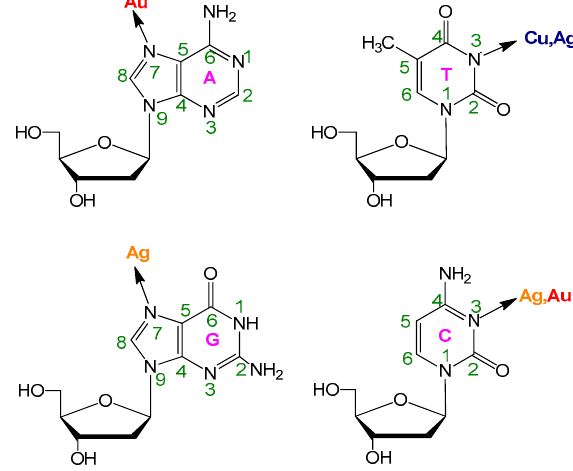
Figure 1. The main DNA nucleoside metal binding sites. Reprinted with permission from Ref. [5]. © 2014 American Chemical Society.